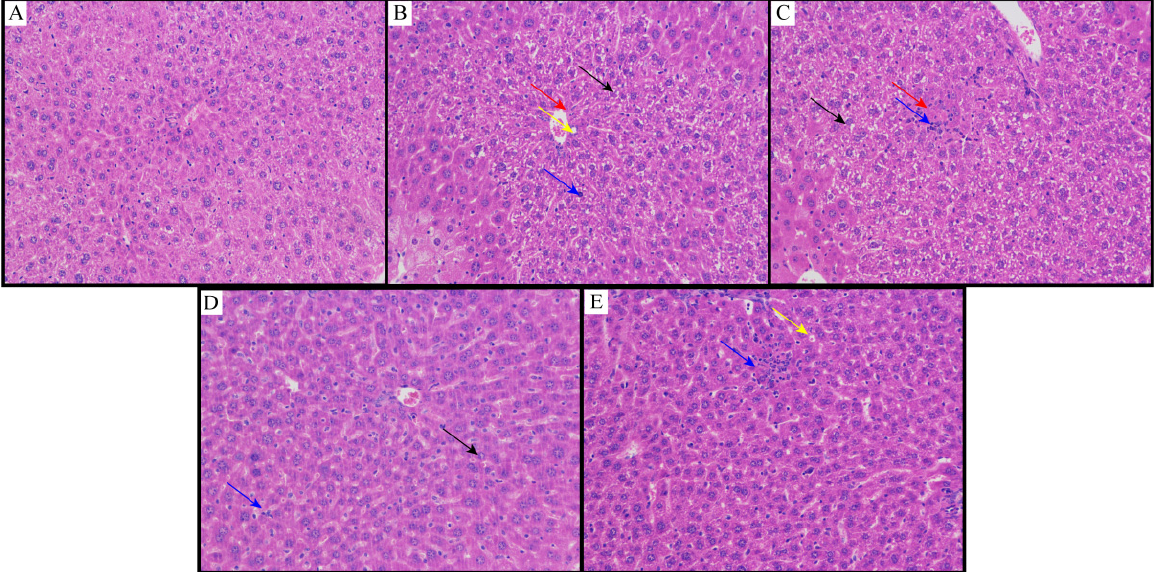
Figure 5. Liver slices of ( A ) NCG; ( B ) NMG; ( C ) MPG; ( D ) HPG; ( E ) CCG. Eight animals of each group were investigated (proliferative connective tissue: red arrow; loose cytoplasm: black arrow; cytoplasmic vacuolation: yellow arrow; lymphocytes and neutrophil infiltration: blue arrow).